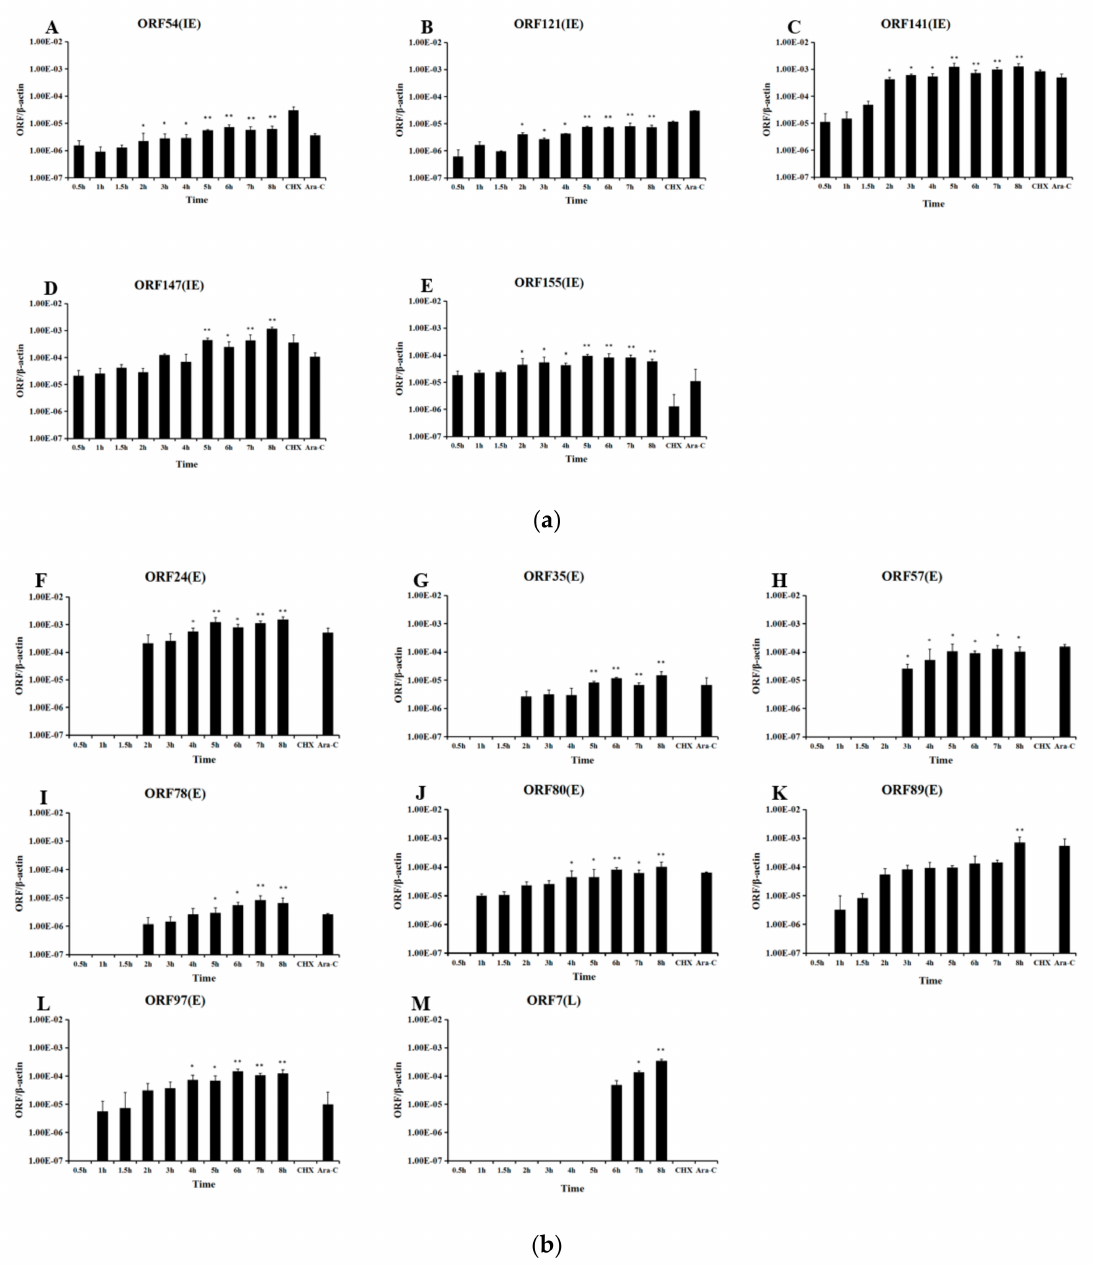
Figure 9. Quantification of CyHV-2 ORF transcripts at indicated time points. Cells were infected with CyHV-2 and treated with no inhibitor, CHX at 300 µ g / mL CHX or Ara-C at 12 µ g / mL Ara-C before RNA extraction and RT-PCR, followed by cDNA synthesis. The amount of amplified cDNA was normalized to that of the actin mRNA present in the same sample. Genes that were expressed up to 2 h are divided into immediate-early (IE) genes ( A ): ORF54 , ORF121 , ORF141 , ORF147 , and ORF155 ; genes that begin to be expressed between 2 and 4 h are early (E) genes ( B ): ORF24 , ORF35 , ORF57 , ORF78 , ORF80 , ORF89 , and ORF97 ; and genes that begin to be expressed after 4 h are late (L) genes ( C ): ORF7. Error bars represent the standard deviation of the mean of experiments performed in triplicate. o significant di ff erence, * p ≤ 0.05 and ** p ≤